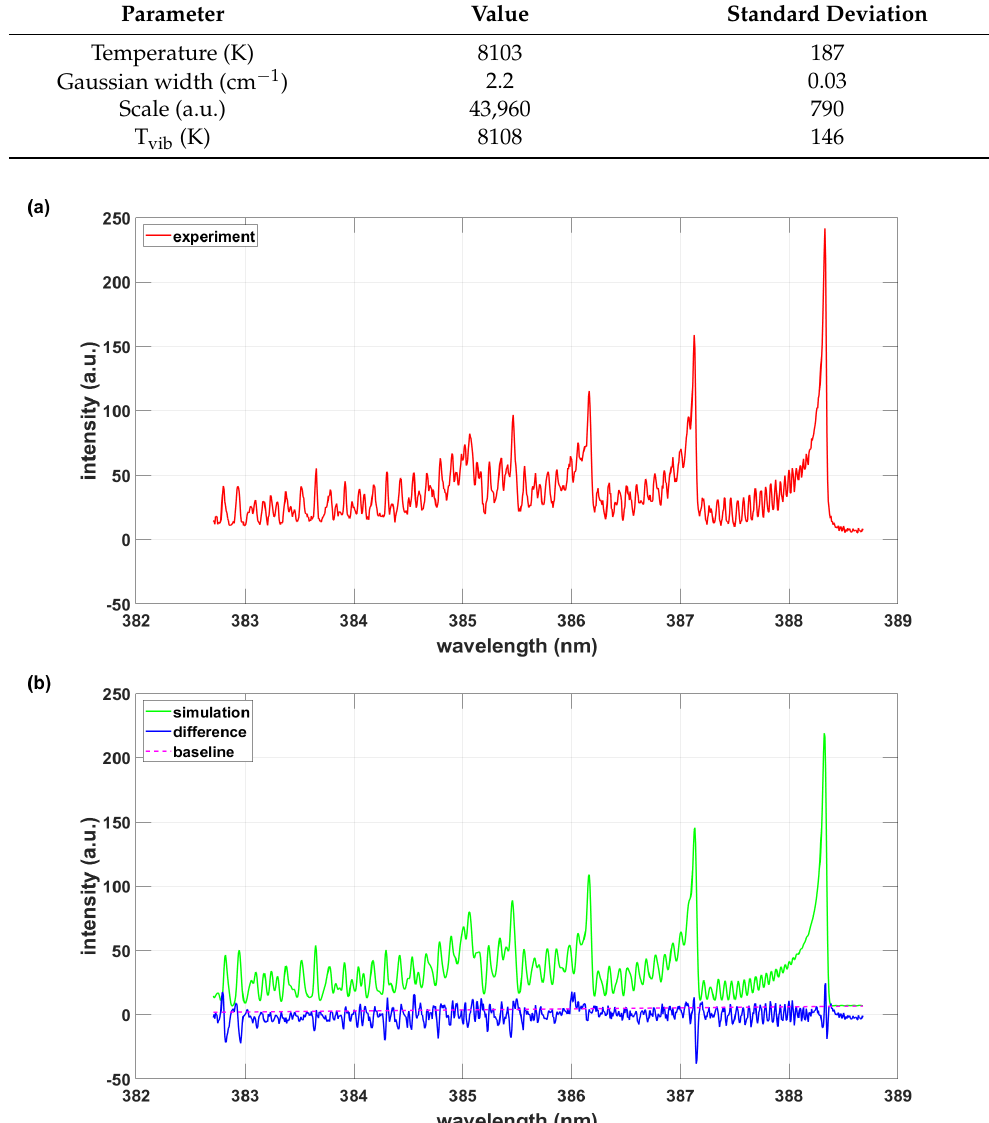
Figure 1. ( a ) Experimental spectrum; ( b ) simulation with PGOPHER, T = 8103 K, ∆ λ = 0.033